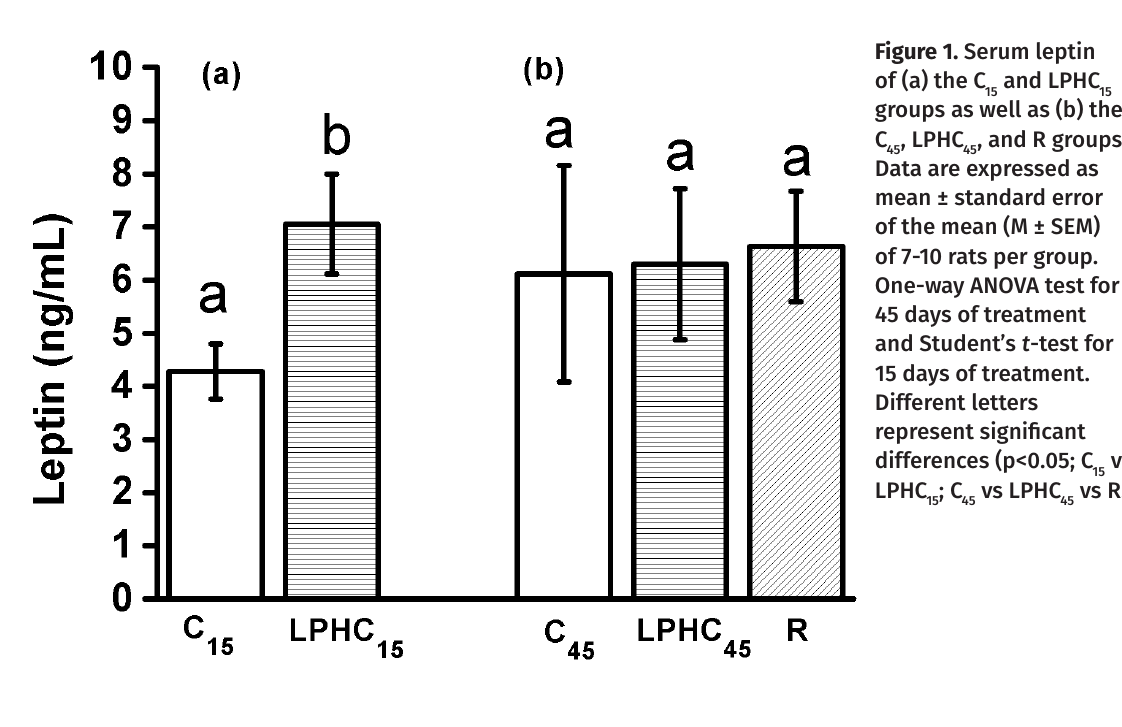
Table III. White adipose tissue weight and adiposity index of the C Variables